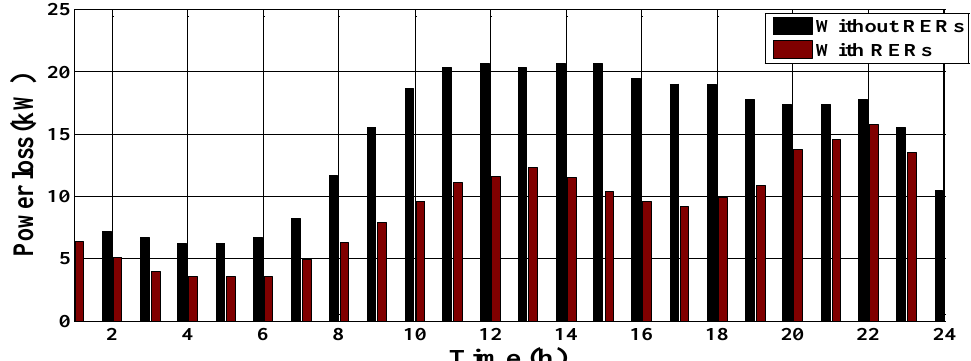
Figure 8. Power losses with and without RERs.